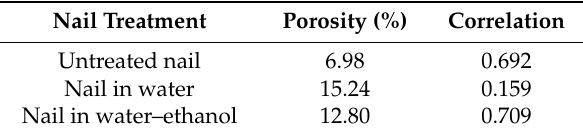
Table 2. Porosity of treated and control human nail clippings and correlation values obtained by PIM and ensuing data analysis and modelling with PoreXpert software.